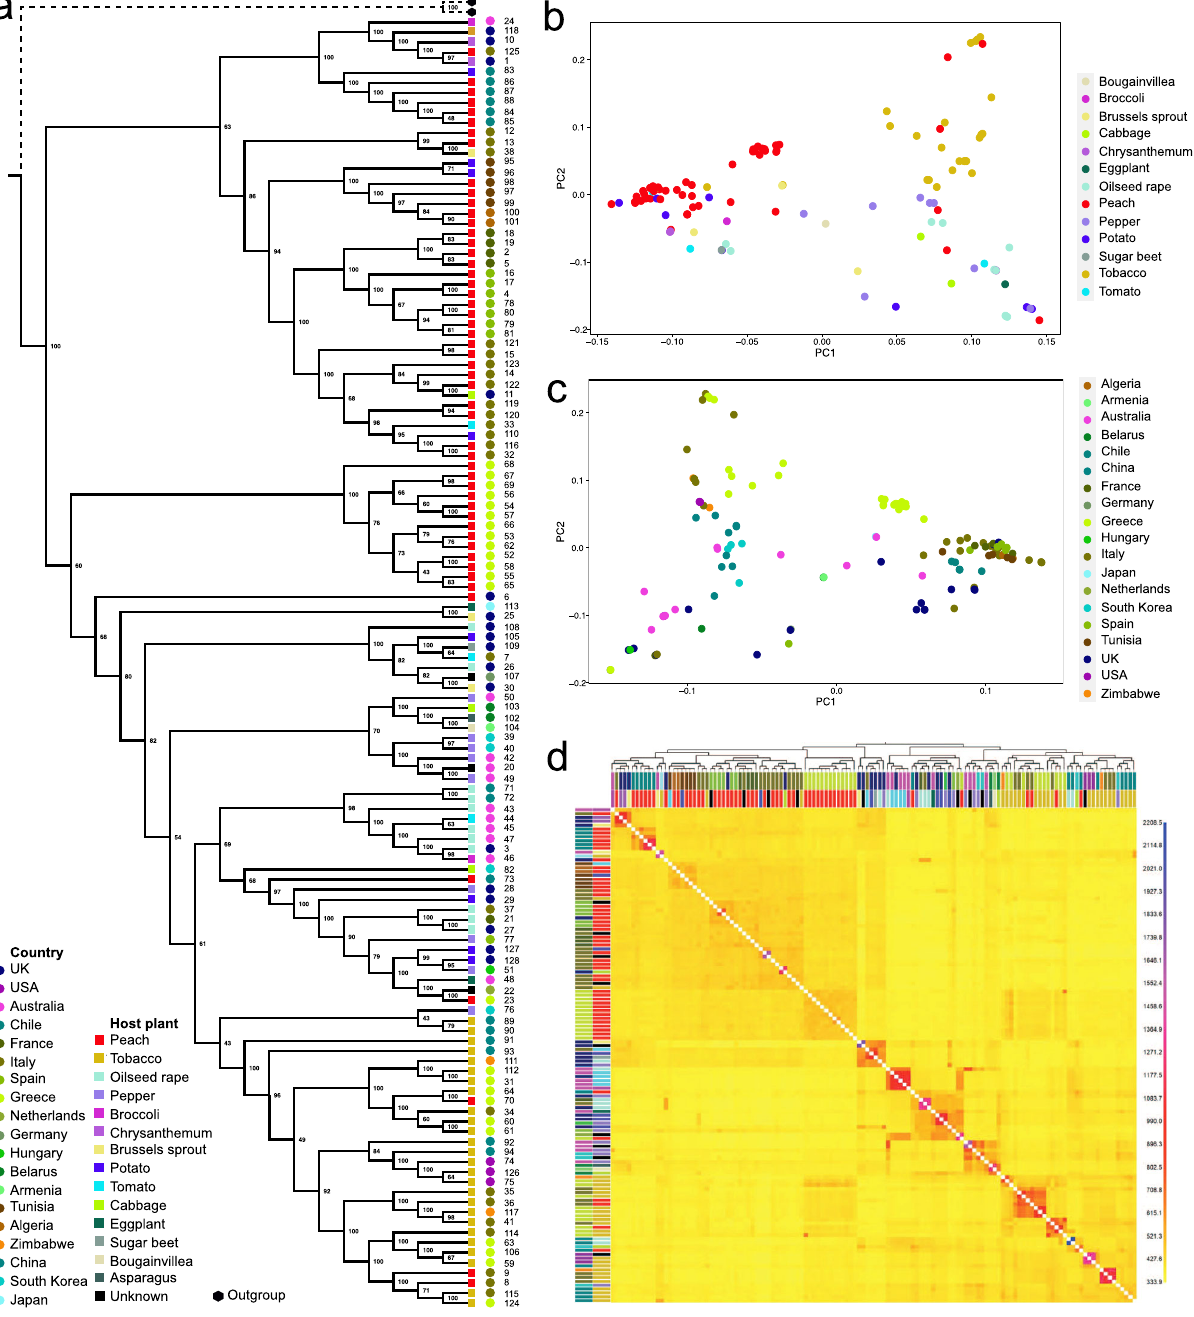
Fig. 2 Phylogenetic relationship and population structure of 127 M. persicae clones. a Maximum likelihood phylogeny based on >1 M biallelic SNPs. Data from two samples of Myzus cerasi were used as an outgroup. The geographic origin of clones and the host plant from which they were collected are indicated by coloured circles and squares respectively. Clone identi fi cation numbers (corresponding to Supplementary Data 1) are also included. For a representation of the tree as a phylogram see Fig. S1. b , c Principal component analysis of genetic diversity between clonal lines with samples coloured by host plant ( b ) or geographic origin ( c ). d Coancestry heatmap of the sampled clones derived from fi neSTRUCTURE analysis. The scale shows the degree of shared genetic chunks between the lines (lower, yellow, to higher, blue). The maximum a posteriori (MAP) tree generated by fi neSTRUCTURE showing the relationship between samples is shown above the heatmap. The geographic origin of clones and the host plant from which they were collected are indicated by the outer and inner coloured rectangles respectively (see PCA keys for interpretation of (Fig. 4). Curation of genes residing in 15 of these peaks per autosome however, further functional analyses are required to test this identi fi ed genes encoding a range of biological functions, including hypothesis. It is also important to acknowledge that genetic olfactory recognition, digestion, detoxi fi cation and excretion, and differentiation between insect host-plant lineages at speci fi c loci can nucleic acid binding (Supplementary Data 4). The function of these result from a range of extrinsic and/or intrinsic factors that may be genes suggests roles in host plant recognition and exploitation; functionally unrelated to host – plant specialization 35 . For example, in